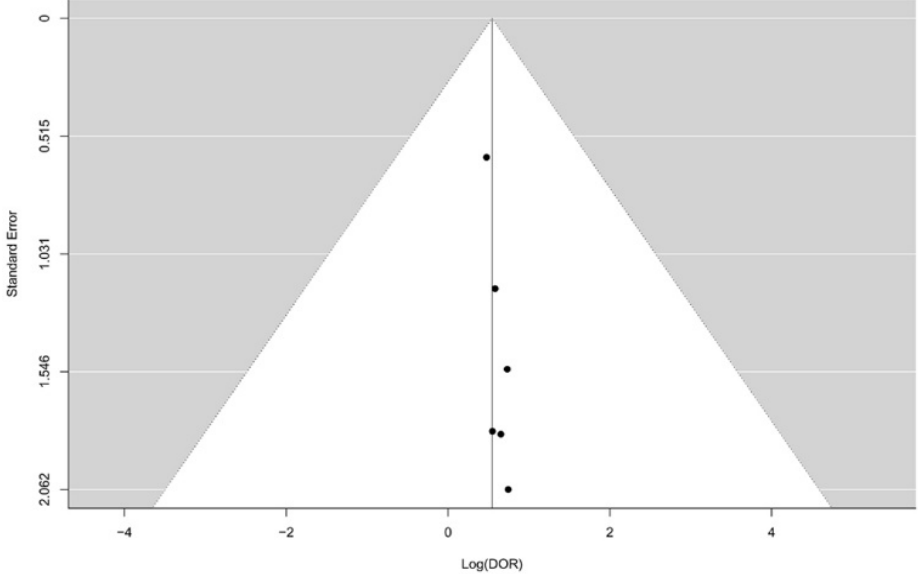
Figure 2. Funnel plot with pseudo 95% confidence intervals, using data from the six studies, with log-diagnostic-odds-ratios displayed in the horizontal axis, indicating that there was probably no publication bias in the included studies.